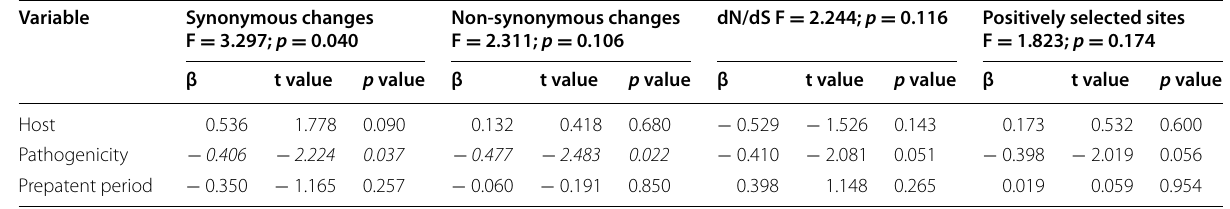
Table 4 Results of multiple regression analysis of each of the four genetic parameters and the three factors related to Eimeria